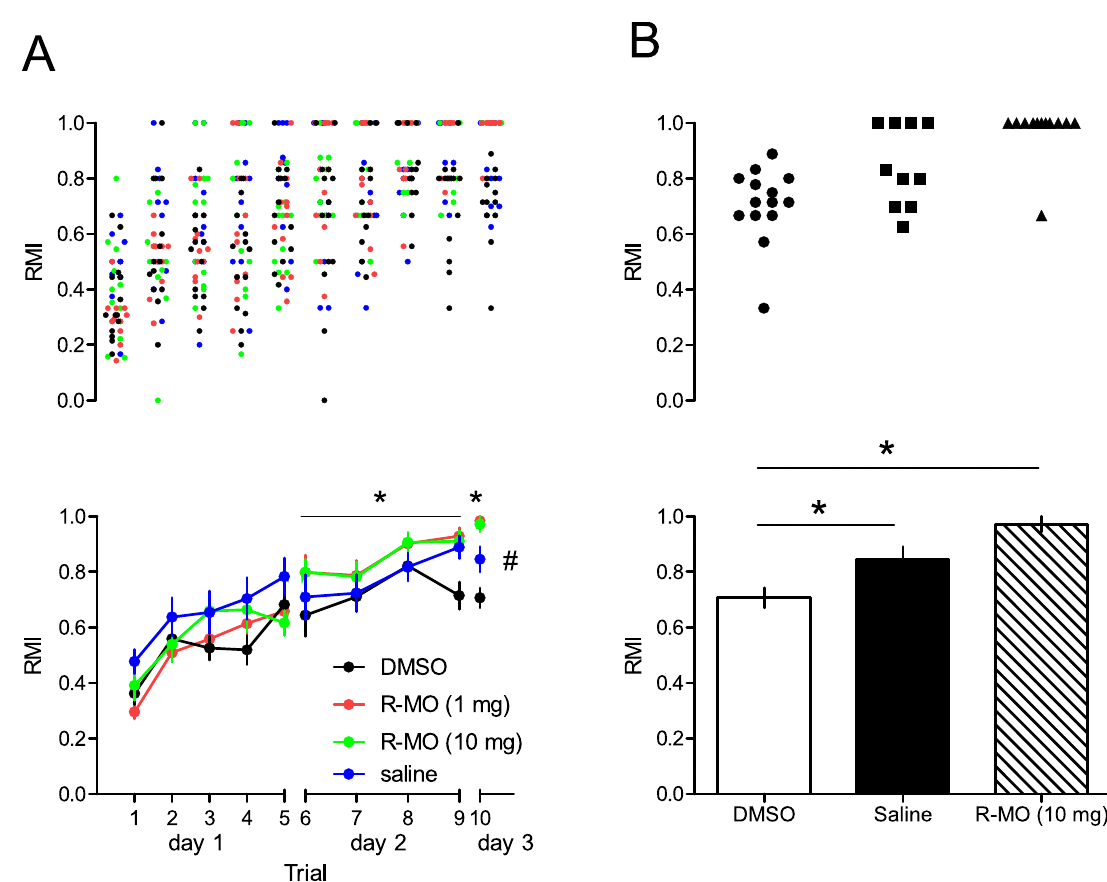
Fig 3. Spatial learning and memory in the Hole-board. The performance was significantlybetter with improved RMI during day 2 and duringretrieval (trial 10) on day 3 of the hole-board testing (A). (B) detaileddata presentation for trial 10. Lower panels show the mean ± SEM and the upper panels the individualdata points. Two-way repeatedmeasureANOVA for day 1 & 2 and univariate ANOVA on day 3 were used. * p < 0.05, DMSO vs R-MO 1 & 10 mg/kg. # p < 0.05, DMSO vs saline.